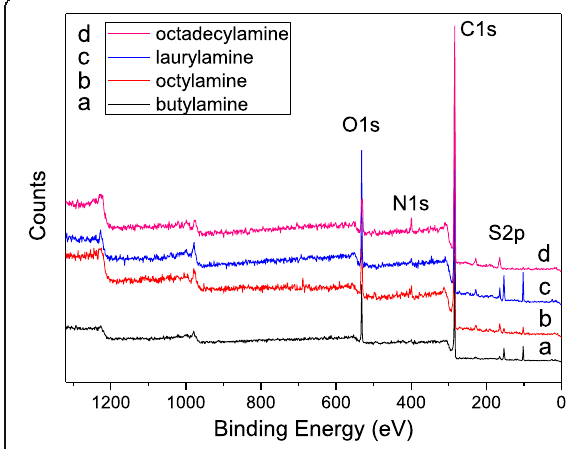
Fig. 1 The XPS survey of the SA-GO which is prepared by the reactions of butylamine ( a ), octylamine ( b ), laurylamine ( c ), octadecylamine ( d ), and the sulfur-doped graphene oxide (the oxidation time of the graphene oxide is 24